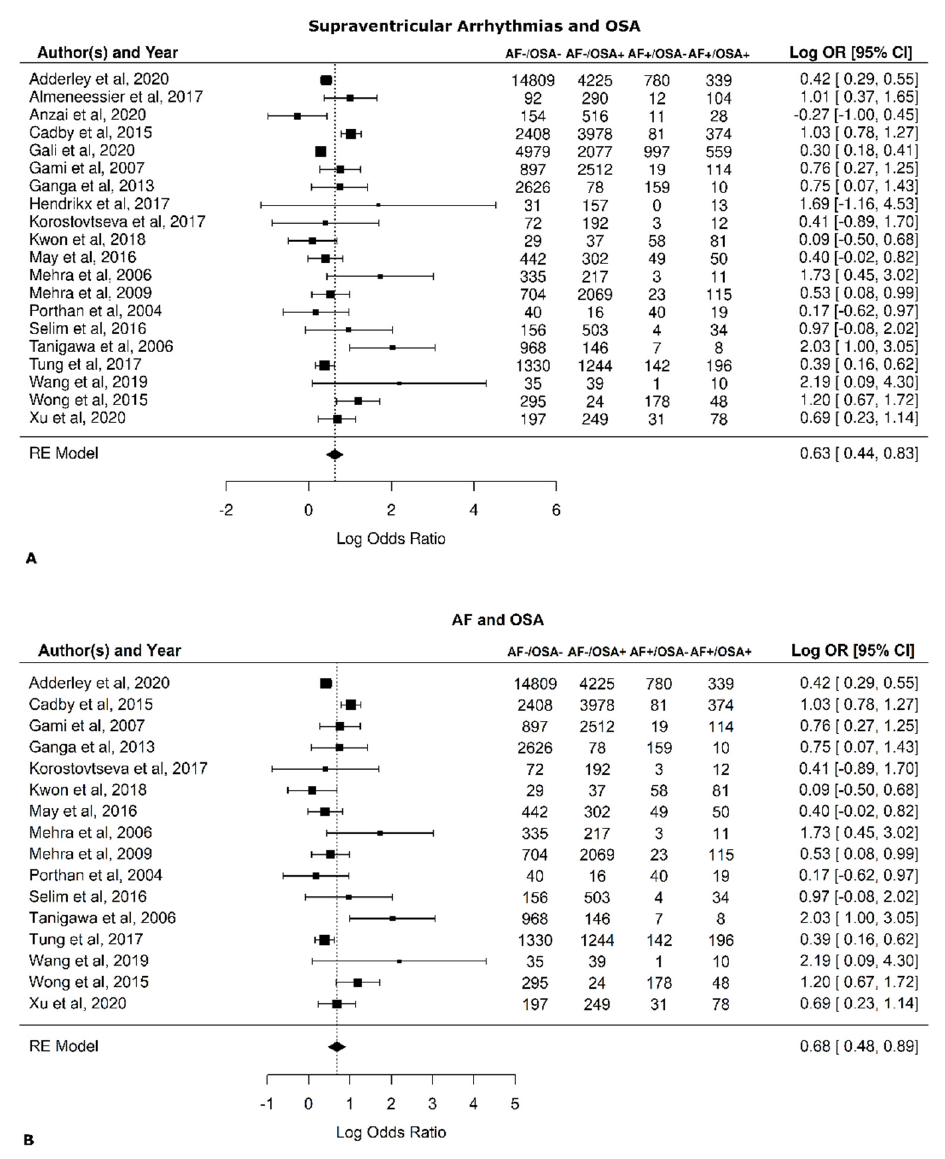
Figure 2. Risk of atrial fibrillation (AF) in patients with obstructive sleep apnea (OSA). Forest plots. ( A ) All references, including those that did not discriminate between arrhythmia in general and AF, were examined [30,39,40–57]. ( B ) Only references that include only AF were examined [39,41,43,44,46–57].